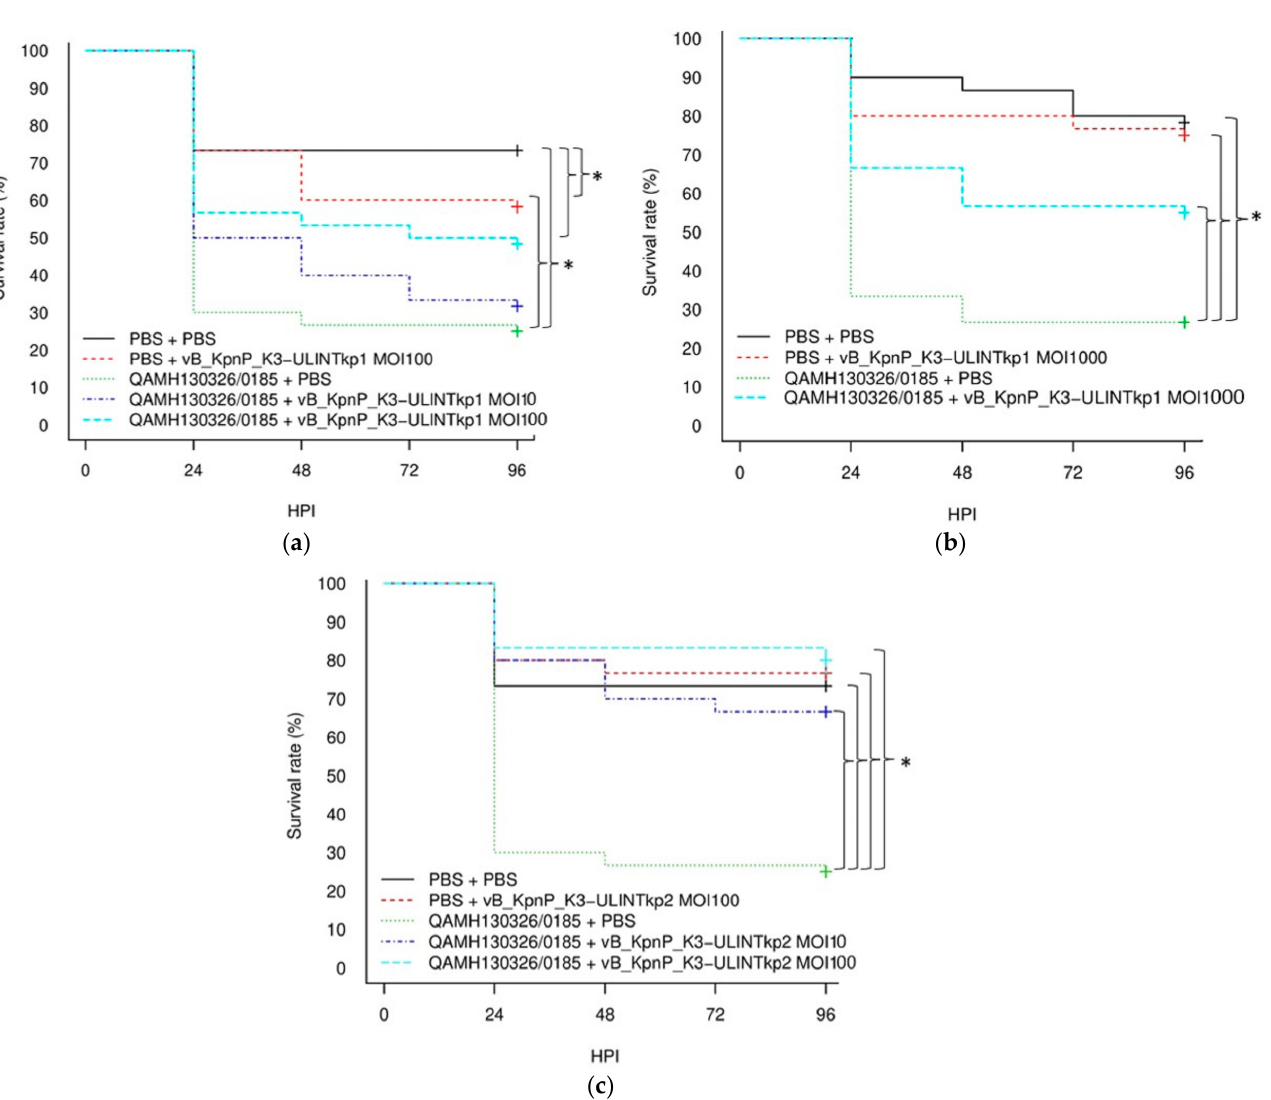
Figure 6. Low MOI bacteriophage kinetic curves of the bacteriophages vB_KpnP_K3-ULINTkp1 (blue curve) and vB_KpnP_K3-ULINTkp2 (orange curve).